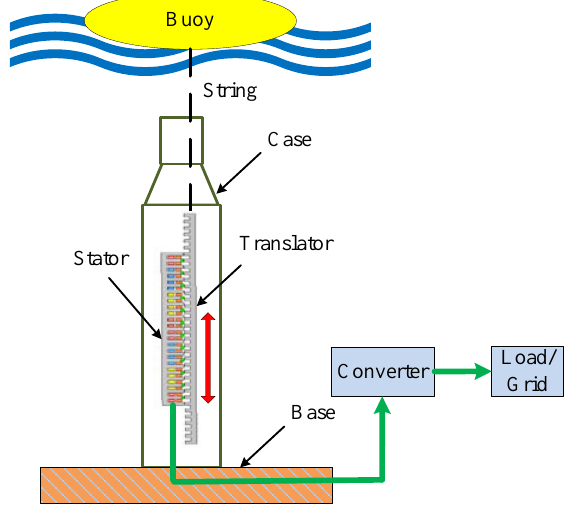
Figure 1. A buoy-type direct-drive wave energy converter.